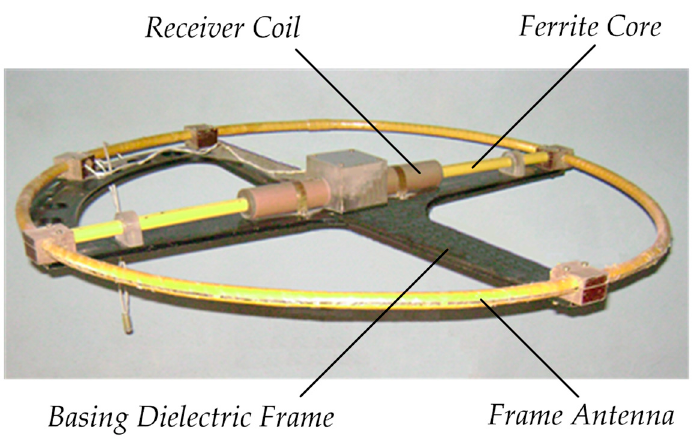
Figure 5. Pilot induction probe: a design version.